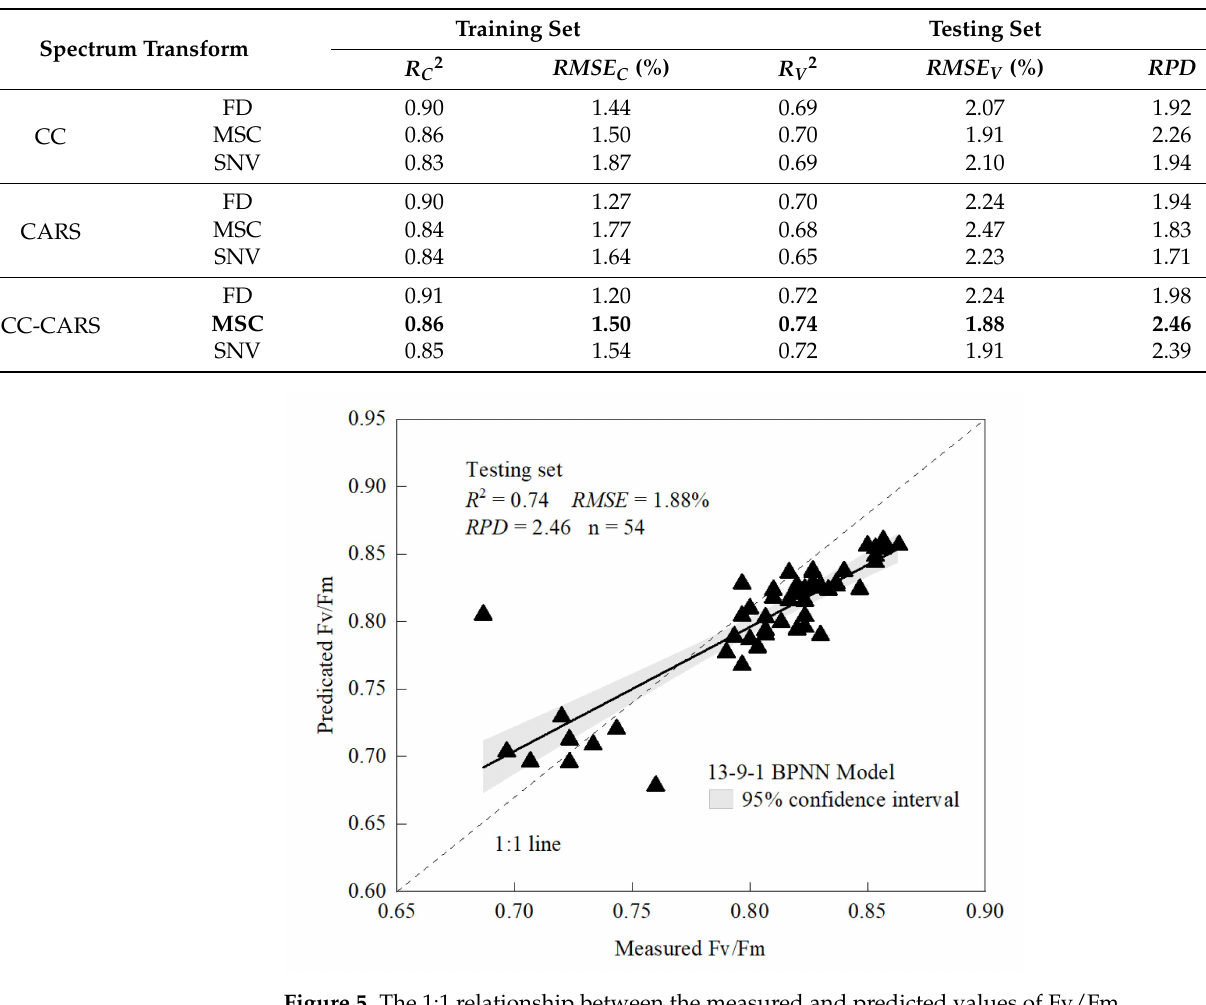
Figure 5. The 1:1 relationship between the measured and predicted values of